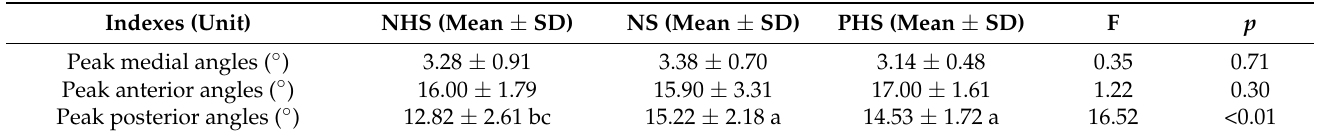
Table 3. Mean values, standard deviations, and results of the repeated measures ANOVA for peak COM-COP inclination